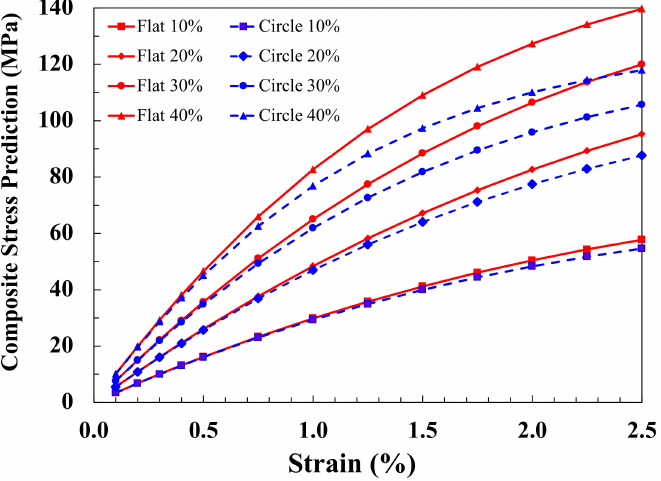
Figure 8. Kelly–Tyson equation prediction of stress–strain of injection moulded GF-PP with flat ( K = 4) and circular cross-section